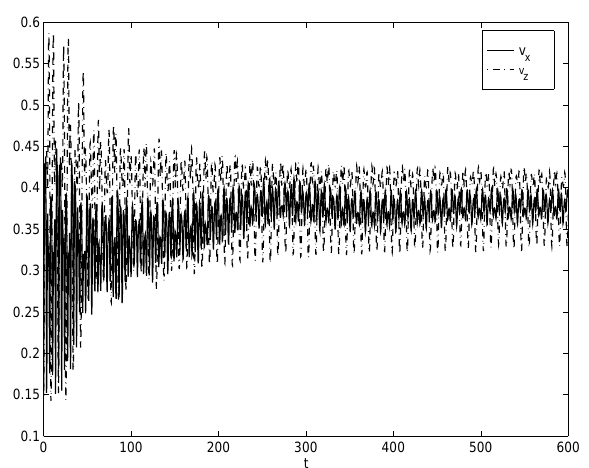
FIG. 21. rms velocities (in arbitrary units) for the 6D station- ary distribution with strong initial mismatch ( (cid:99) (cid:121) (cid:97) (cid:173) (cid:51)(cid:44) m (cid:120) (cid:173) m (cid:121) (cid:173) m (cid:122) (cid:173) (cid:49)(cid:46)(cid:53)(cid:44) h (cid:120) (cid:173) (cid:48)(cid:46)(cid:53)(cid:51)(cid:44) h (cid:122) (cid:173) (cid:48)(cid:46)(cid:51)(cid:57) ).